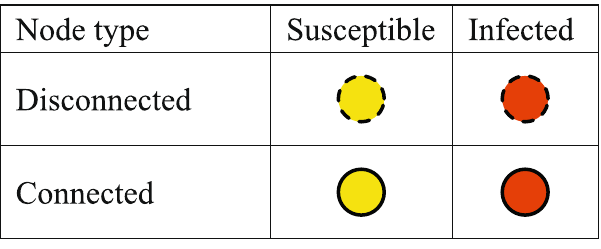
Figure 3. Four types of